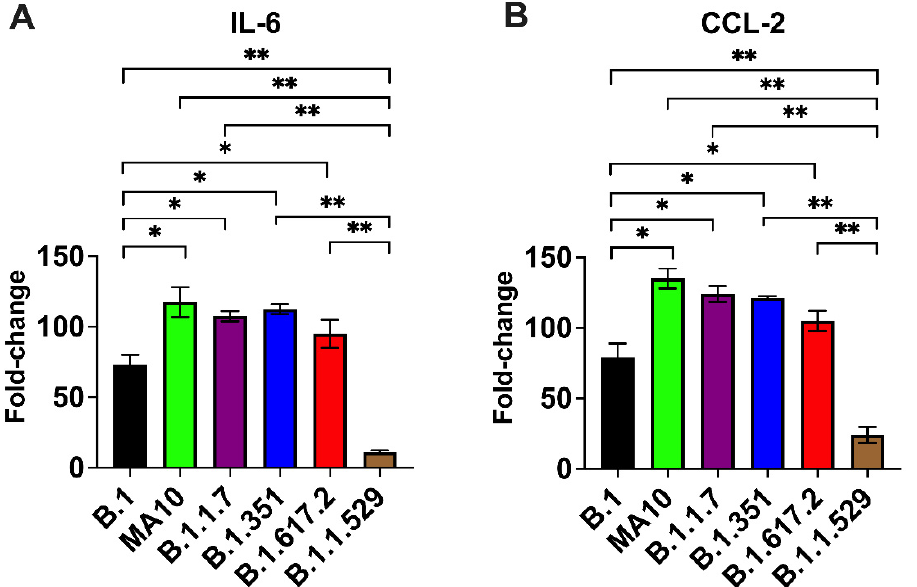
Figure 3. Analysis of inflammatory response in the lungs. Eight-week-old K18-hACE2 mice were inoculated intranasally with PBS (mock) or 10 4 PFU of SARS-CoV-2 or variants ( n = 5–7 mice per group). Lungs and brain were harvested after extensive perfusion with PBS and RNA was extracted.